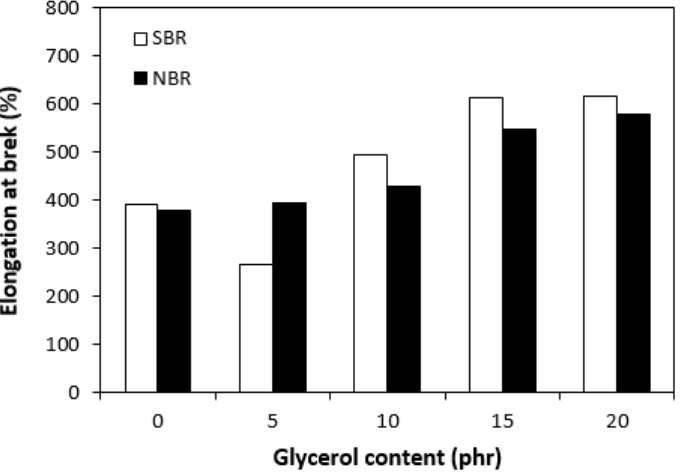
Figure 13. Influence of glycerol content on elongation at break of vulcanizates.